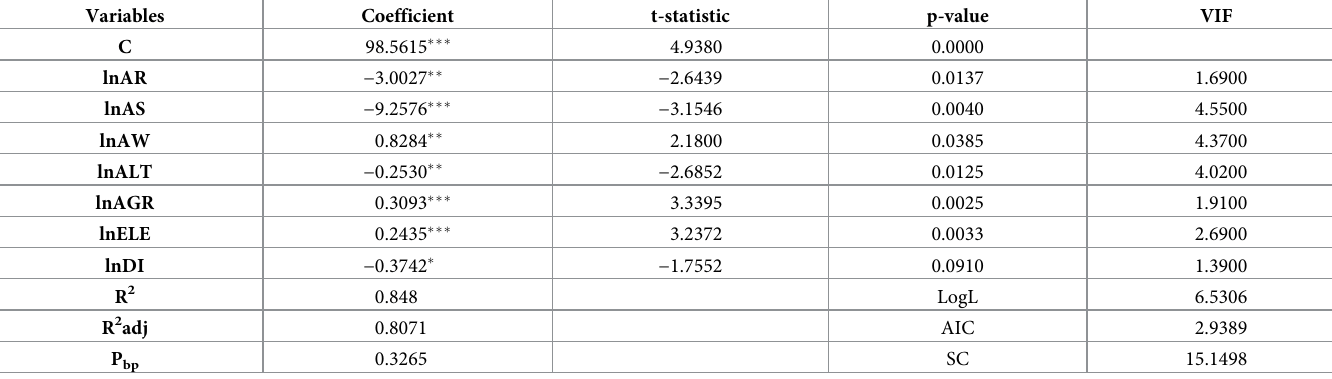
Table 3. OLS model parameter estimation and test